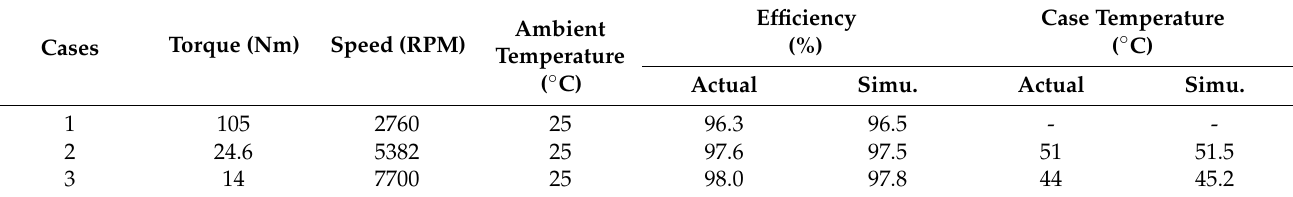
Table 4. Actual vs. simulation validation.